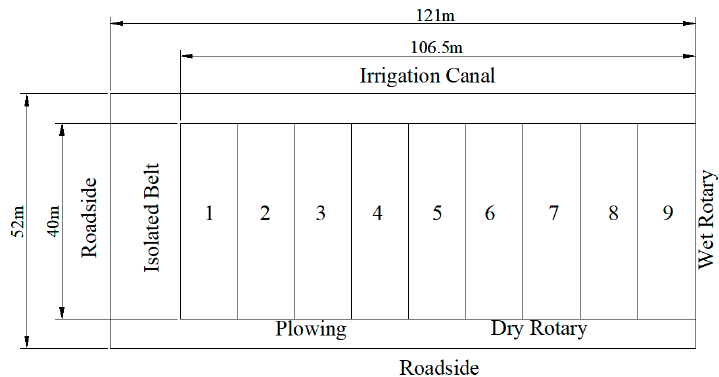
Figure 3. Field layout.